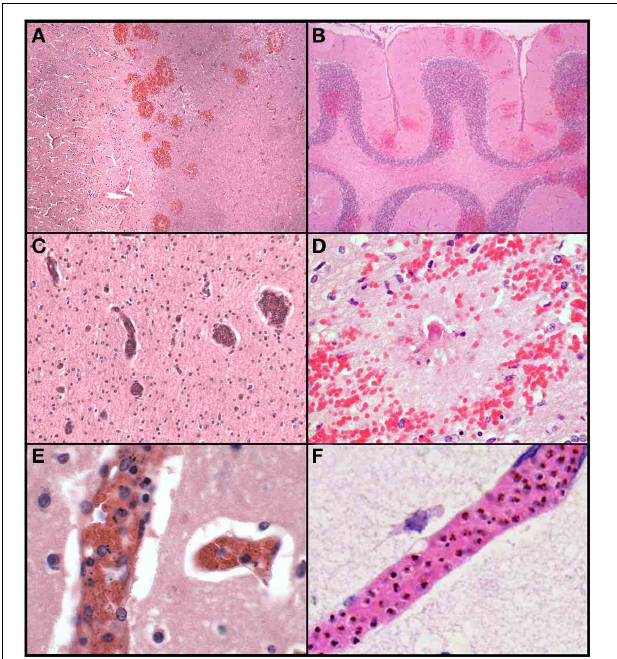
FIGURE 3 | A summary of representative images from the histological examination of the brain in the autopsy series is shown for CM cases. The abrupt transition from gray to white matter (A) and the presence of ring hemorrhages are demonstrated in this classic case of CM (CM2, 100X, H&E). The cerebellum (B) with ring hemorrhages in all levels including white and gray matter are shown (100x, H&E). Visibly congested blood vessels (C) even at low power may be the result of dense sequestration downstream; these vessels can contain both parasitized and uninfected red bloods (200X, H&E). The classic appearance of a ring hemorrhage with fibrin (D) is shown; these hemorrhages can also include pigmented parasites, free pigment, and admixed fibrin within the microvessel at the nexus of the lesion; uninfected erythrocytes constituting the surrounding hemorrhage are seen (400X, H&E). Two examples of sequestration showing predominantly early (less pigmented) parasites (E) , and late stage (more pigmented) parasites (F) densely packing vessels (1000X,